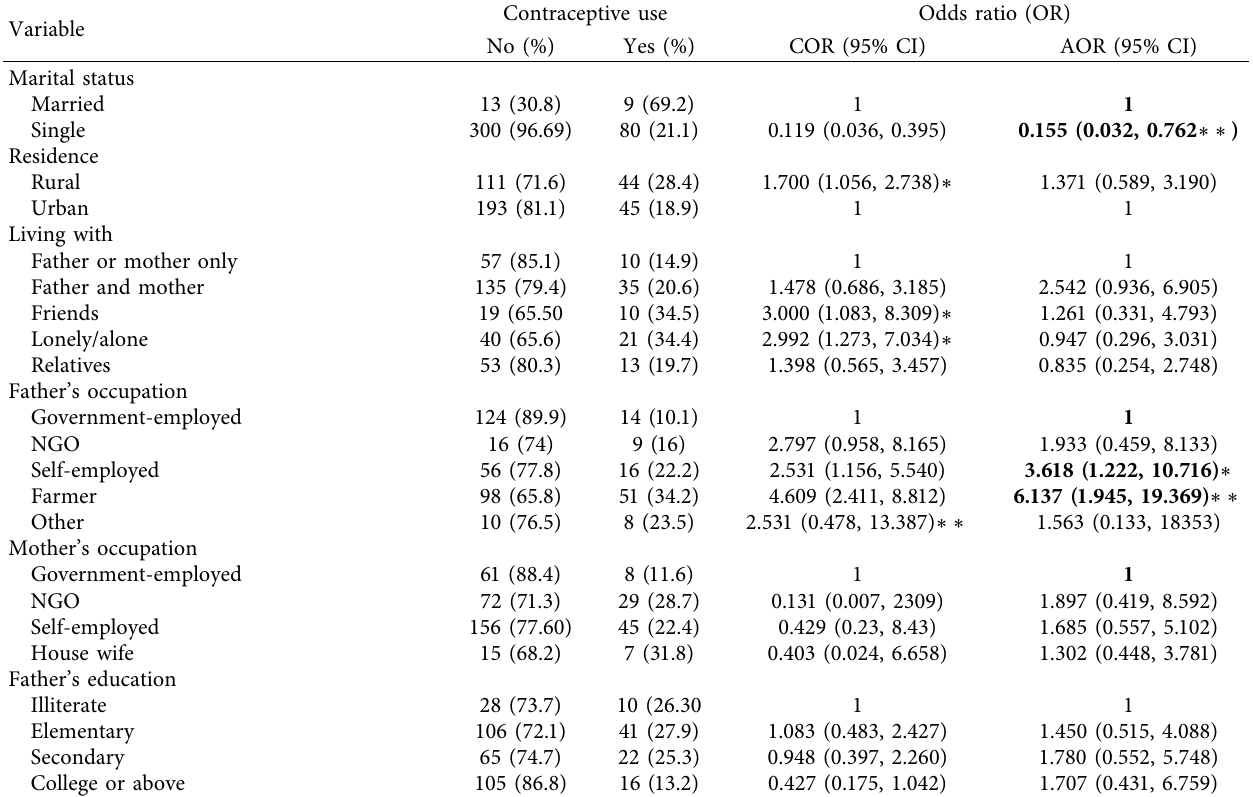
Table 6: Factors affecting practice of reproductive health rights among preparatory school female students, Assela, Ethiopia, 2015.